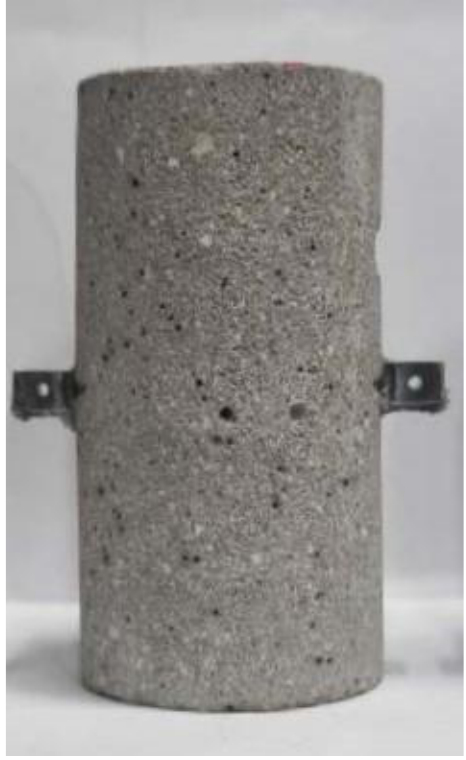
Figure 5. Test specimen with two lateral Perspex blocks attached for target marker